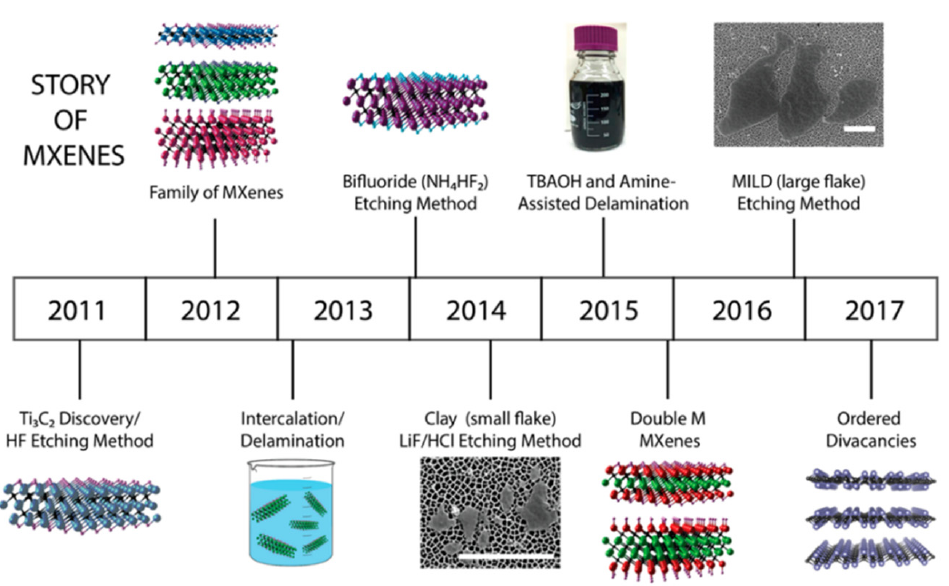
Figure 6. Stages of the MXenes development. Reprinted with permission from [57]. Copyright © 2017 American Chemical Society.